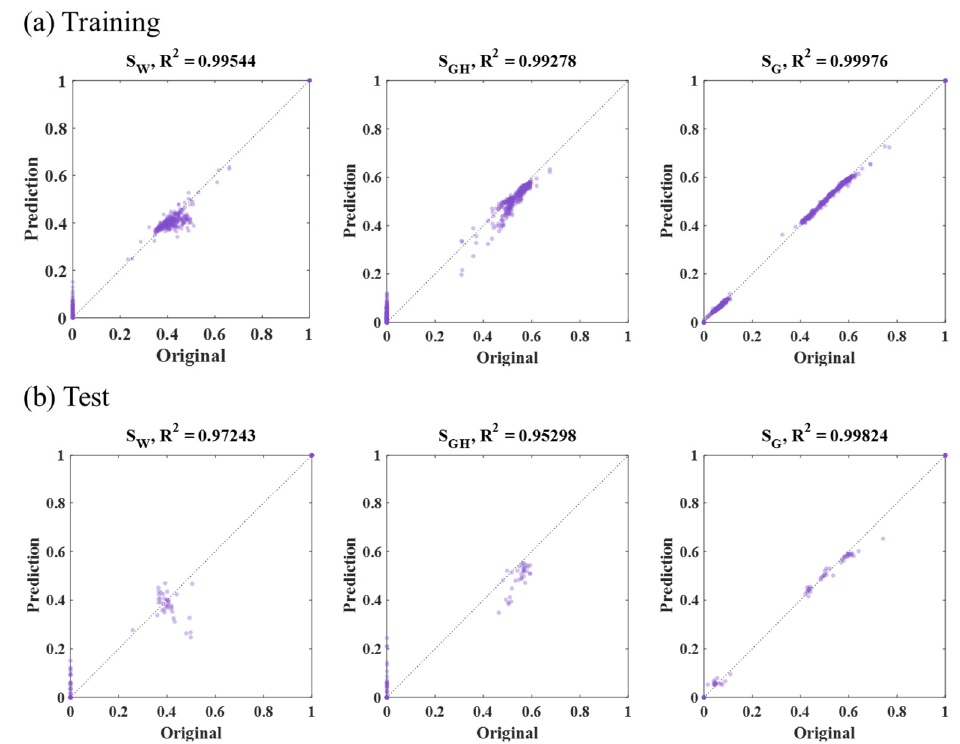
Figure 11. ( a ) Training and ( b ) test results from the RF.